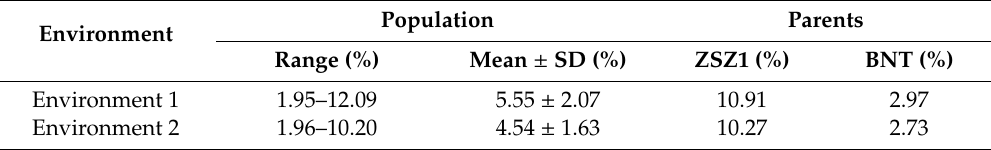
Table 1. Descriptive statistics of the trait of fiber lignin content for the parents and the population. Population Parents Environment Range (%) Mean ± SD (%) ZSZ1 (%) BNT (%) Environment 1 1.95–12.09